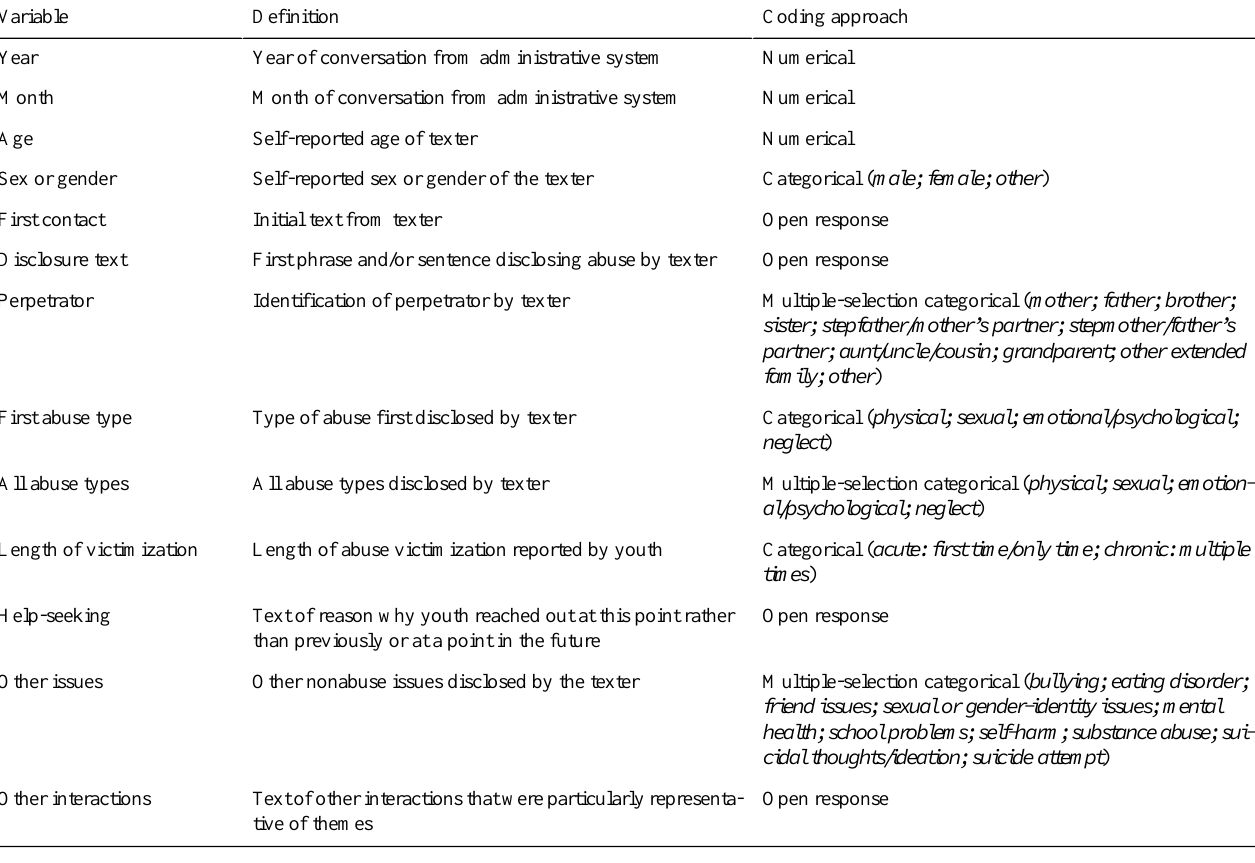
Table 1. Coding scheme of conversations that resulted in a mandatory report.